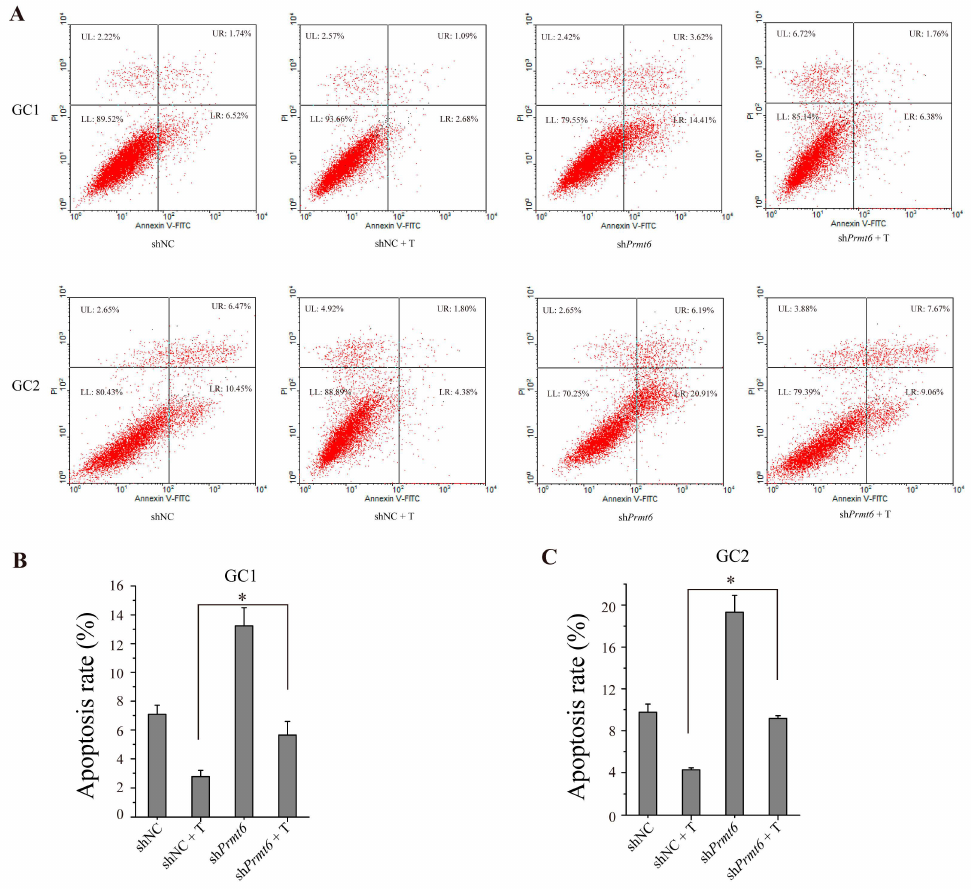
Figure 7. Germ cell apoptosis was promoted by transfecting GC-1 and GC-2 cells with sh Prmt6 and treated with testosterone (T). ( A ) Representative graphs of GC-1 and GC-2 cell apoptosis as analyzed by flow cytometry. LR (lower right section of the graphs) which was Annexin V-FITC positive and PI (propidium iodide) negative represented the percentage of apoptosis cells; ( B , C ) Statistical analysis of the cell apoptosis rate of GC-1 and GC-2 cells. All of the experiments were repeated at least three times. Data are expressed as the mean ˘ SD. * p <